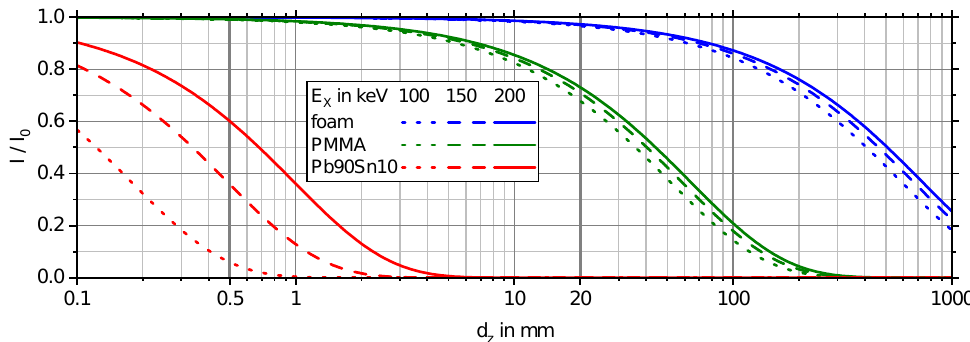
Figure 5. X-ray attenuation characteristics, calculated by Beer–Lambert’s law (Equation (1)): the X-ray transmittance I / I 0 depends on the penetrated material, i.e., its X-ray attenuation coefficient µ X and thickness d z along the X-ray beam direction. In the case of the metal beads (Pb90Sn10, d z ≤ 0.5mm) serving as radiopaque features of the tracer particles in the foam at 10% liquid fraction, the X-ray photon energy E X also has a significant effect on the X-ray